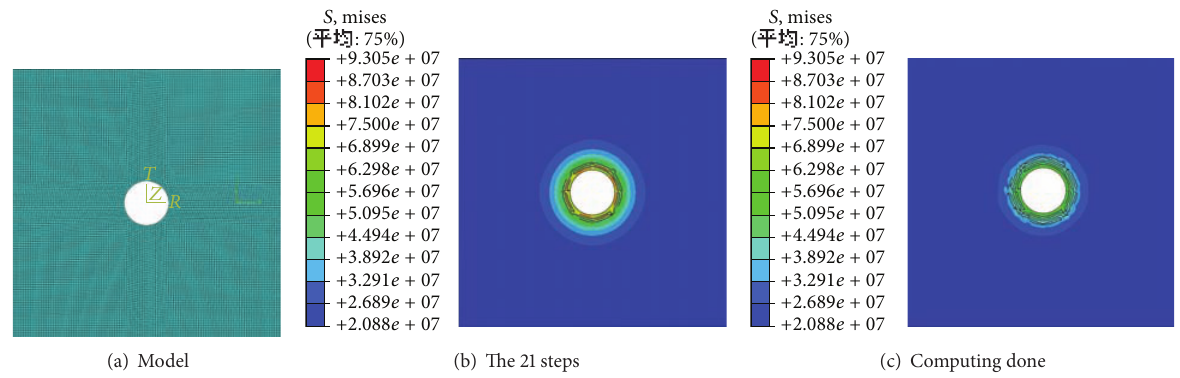
Figure 11: Zonal disintegration phenomenon in surrounding rock mass simulated with XFEM.